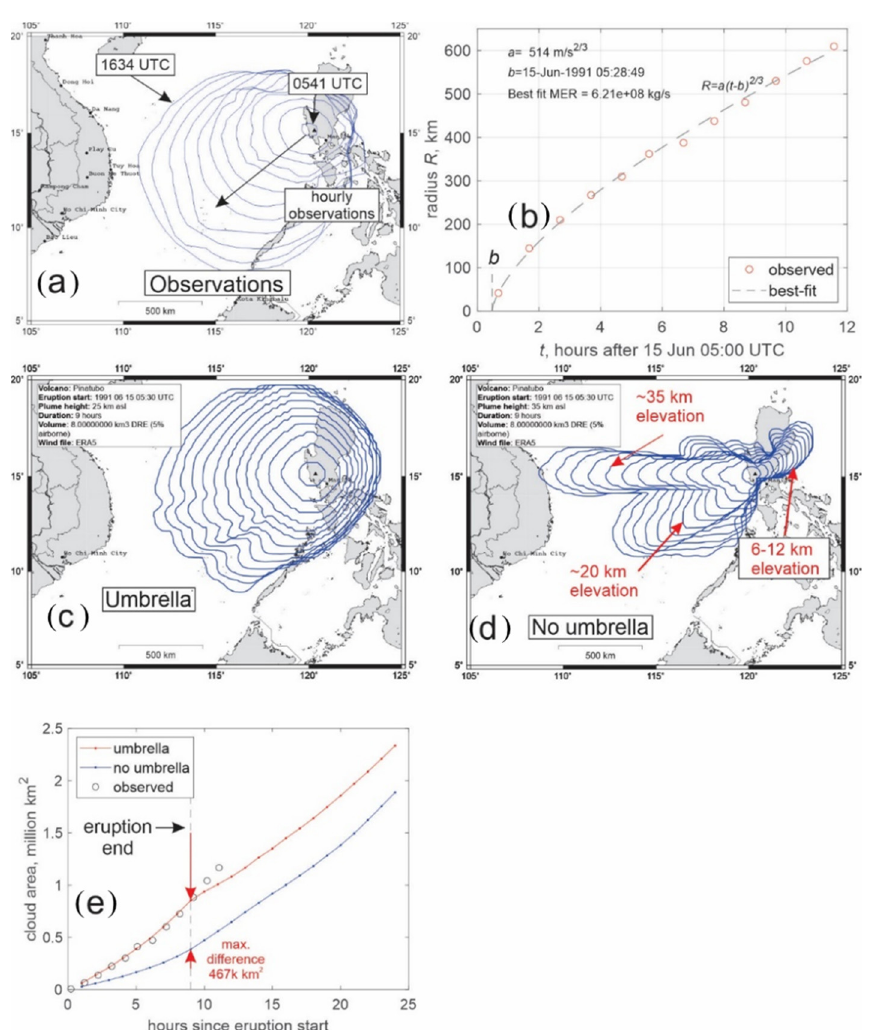
Figure 2. ( a ) Outlines of the growing Pinatubo umbrella on 15 June 1991 as digitized from images of the Geostationary Meteorological Satellite (GMS) satellite in Figure 5b of Holasek, et al. [7]. Blue lines give the outline of the cloud at 05:41, 06:41, 07:41, 08:41, 09:41, 10:34, 11:41, 12:41, 13:41, 14:41, 15:41, and 16:34 UTC. Due to the location of this satellite on the equator at 140 ◦ E longitude, boundaries of the airborne cloud are displaced northward and westward by 32% and 44% of their height, respectively [7]. E ff ects of image distortion and parallax on these outlines have not been analyzed. ( b ) Radius of the Pinatubo cloud versus time in hours after 15 June 05:00. Cloud radius ( R ) is calculated as R = where A is cloud area. The gray dashed line is a best-fit curve of form R = a( t − b) 2 / 3 , where a and b are fitting coe ffi cients having the values shown in the figure. ( c ) Ash3d simulation of the cloud at the same times as in Figure 2a, using inputs from Table 1 and calculating umbrella growth. The cloud margin is defined as the location where the cloud load equals 0.2 g m − 2 . ( d ) Ash3d simulation using the inputs in Table 1, without an umbrella cloud. The location of Pinatubo is indicated by a triangle. ( e ) Cloud area versus time since the eruption start. The circles give the area of the cloud outlines shown in Figure 2a. The red line is the simulated area using the model that considers umbrella growth; the blue line represents the area simulated without considering umbrella